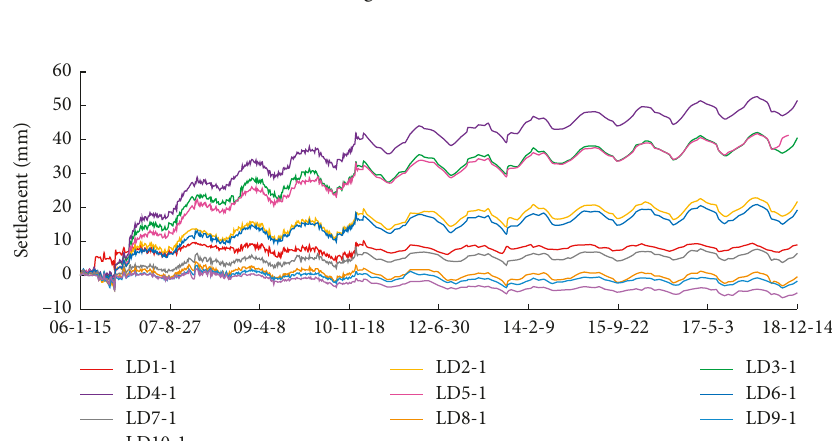
Figure 7: Measured settlements of gauging points LD1-1 to LD10-1.